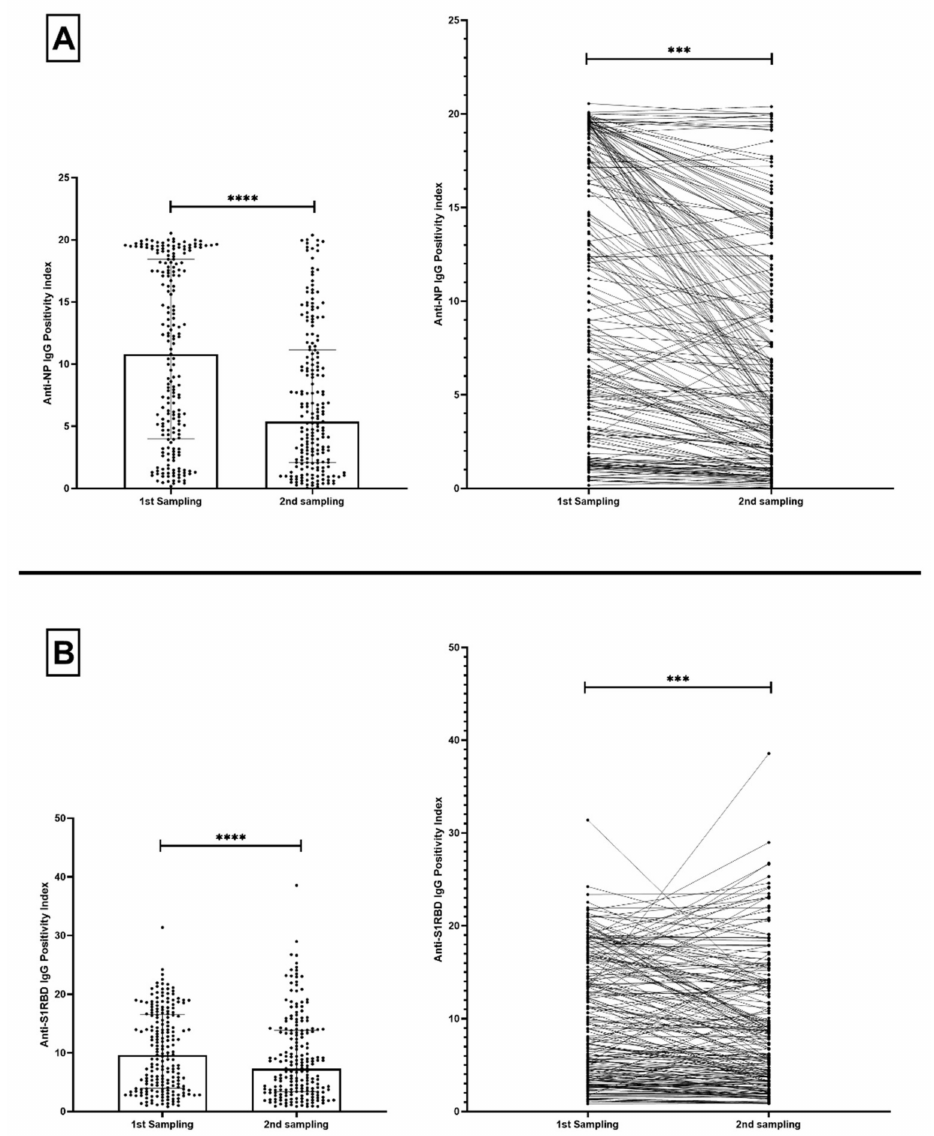
Figure 3. Distribution ( left ) and correlation graph ( right ) of positivity index (P.I.) of ( A ) anti-NP IgG and ( B ) anti-S1RBD IgG antibodies across 2 sampling points of antibody-positive volunteers ( n = 205). Bars represent median and interquartile ranges. *** p <0.001; **** p < 0.0001. A third sample was obtained from 21 antibody-positive volunteers, and the overall change across the three time points was evaluated. The decrease in P.I. of anti-NP IgG was found significant across the three time points, dropping by 10.090% between the first and second sampling and by 35.680% between the second and third samplings ( p < 0.01) (Figure 4A). In contrast, the P.I. decrease of anti-S1RBD IgG was not significant across time, dropping by a total of 13.990% between the first and third samplings (Figure